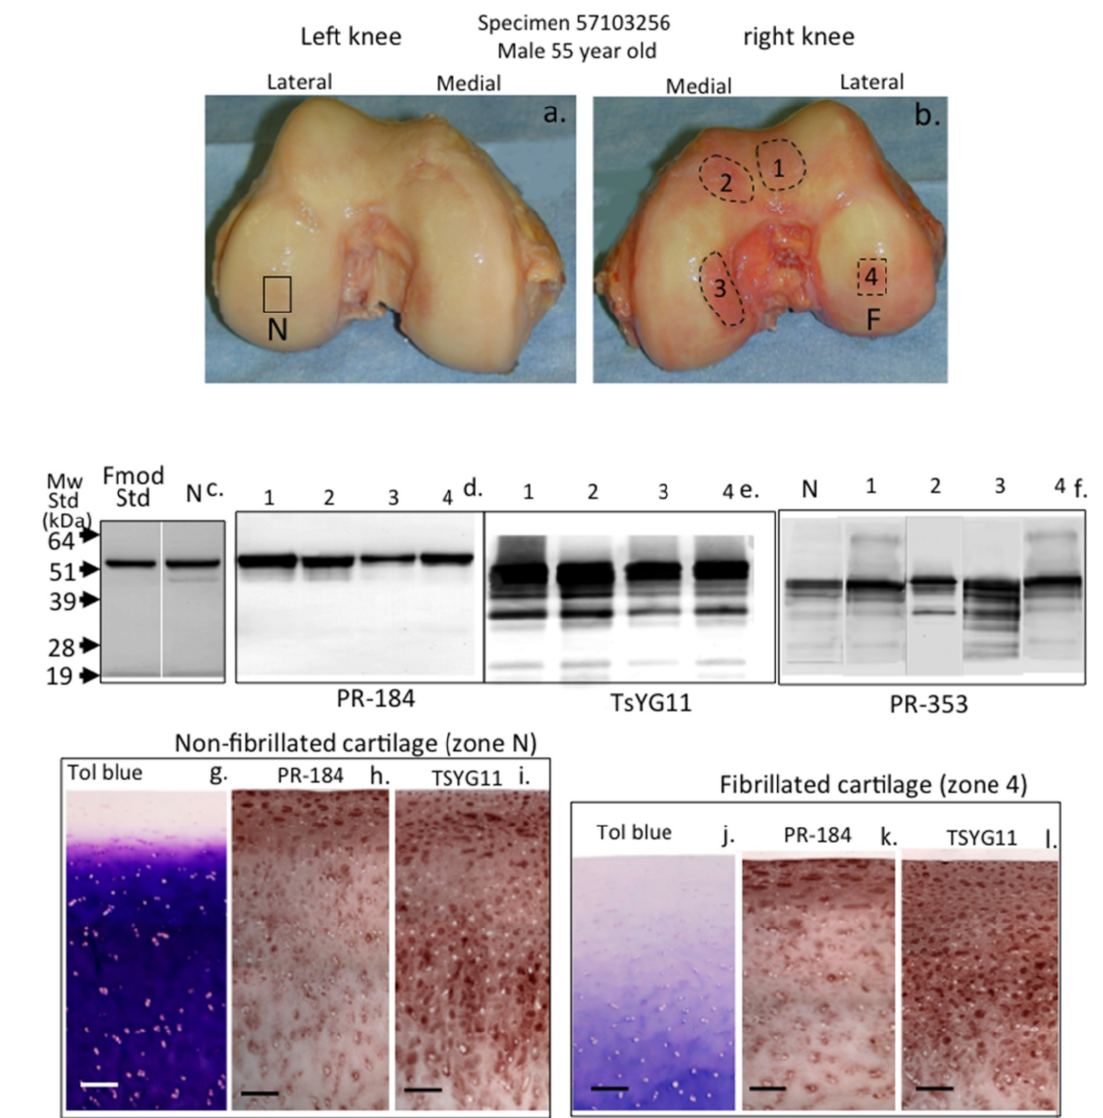
Figure 2. Macroscopic view of human knee femoral condyles from a 55-year-old male ( a , b ) with a normal (N) area devoid of surface fibrillation and four areas of fibrillated cartilage (1–4) which were extracted with 4 M GuHCl and analyzed by Western blotting ( c , d , e , f ) to identify FMOD (pAb PR-184) and MMP-13-cleaved FMOD (pAb TsYG11) and fragmented lumican (LUM) (pAb PR-353) in these regions. Toluidine blue stained proteoglycan distributions in non-fibrillated ( g ) and fibrillated cartilage ( j ) and FMOD ( h , k ) and MMP-13-cleaved FMOD ( i , l ) were also immunolocalized in full thickness cartilage sections from the non-fibrillated region (N) and fibrillated zone 4 (F). The blots shown are representative of three independent experiments. The immunohistology shown ( g – l ) was undertaken on four different tissue sections with qualitatively similar findings to those shown. Scale bar = 100 µ